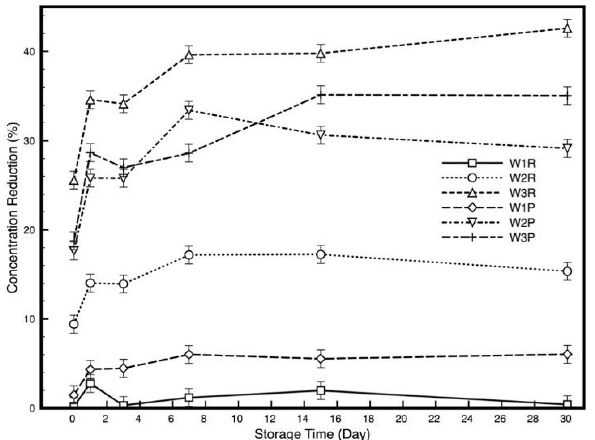
Figure 1. Concentration reduction in ADBAC bulk solution during storage time.